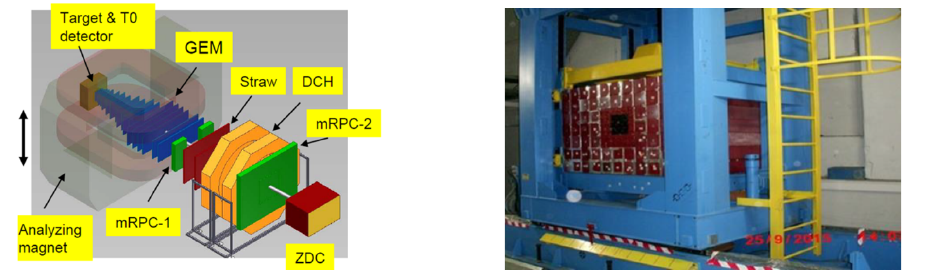
Figure 1. (Left) Schematic view of the BM@N set up. (Right) Photo of the ZDC installed at the end of the BM@N beam